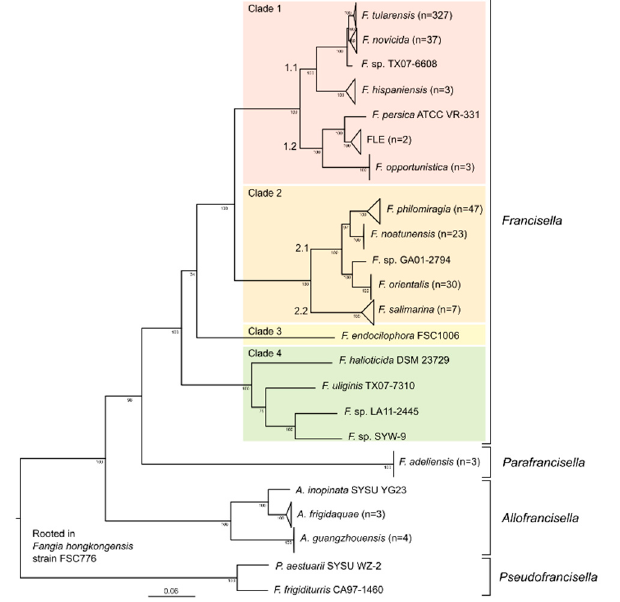
Figure 1. Whole genome maximum likelihood phylogeny of the complete Francisella near neighbor (FNN) dataset calculated with RAxML. Genus Francisella is divided into four separate clades indicated with different colors and numbered 1–4. The four most proximate genera to Francisella are also presented (the complete phylogenetic tree of Francisellaceae is presented in Figure A1).